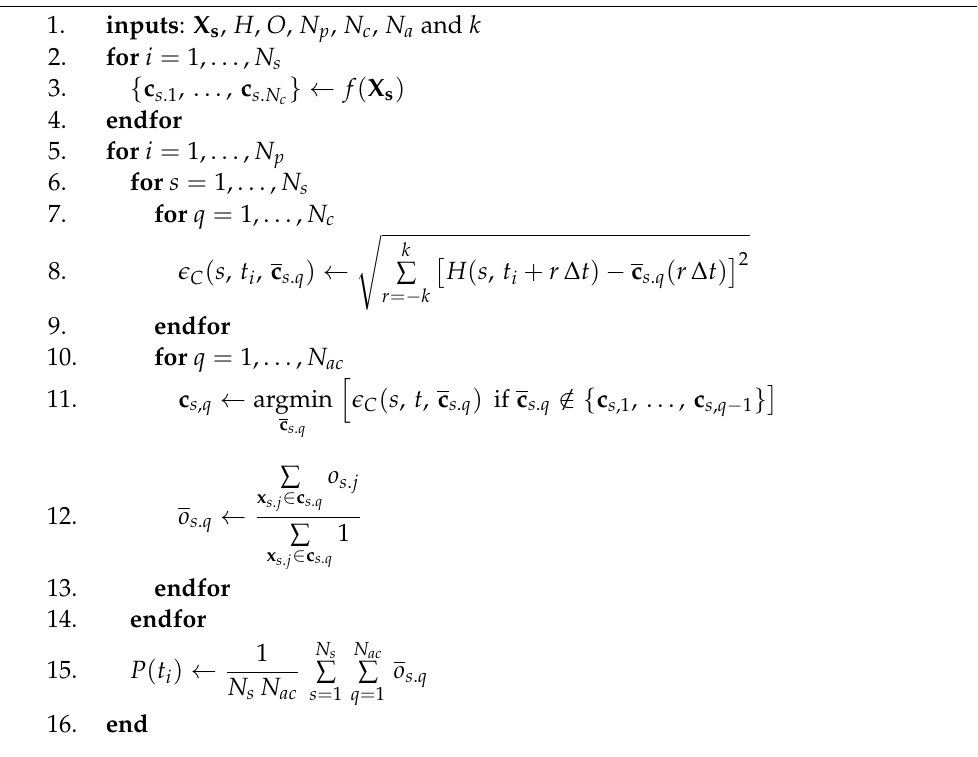
Algorithm 3: Cluster-based AnEn for independent